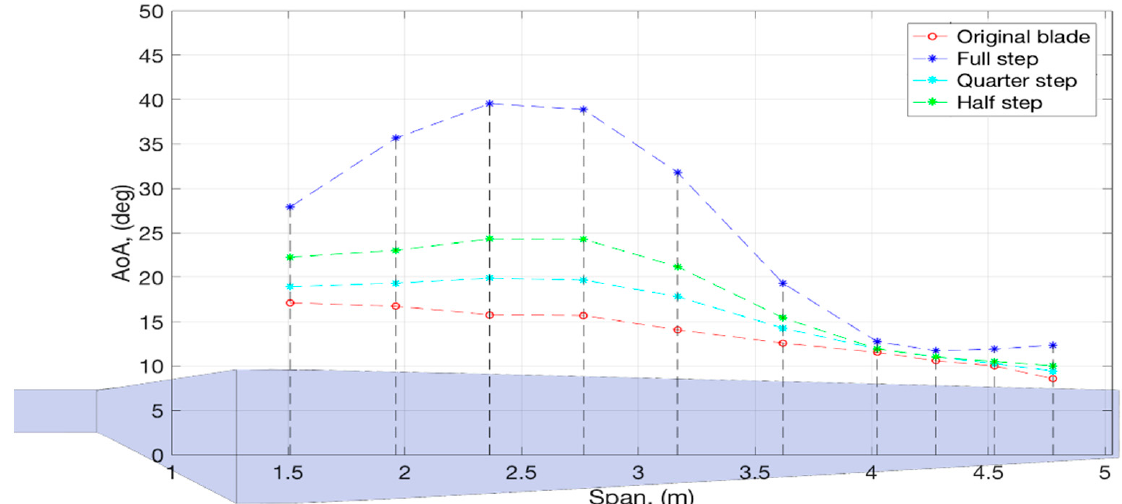
Figure 25. Angle of attack distribution for different blade configurations.